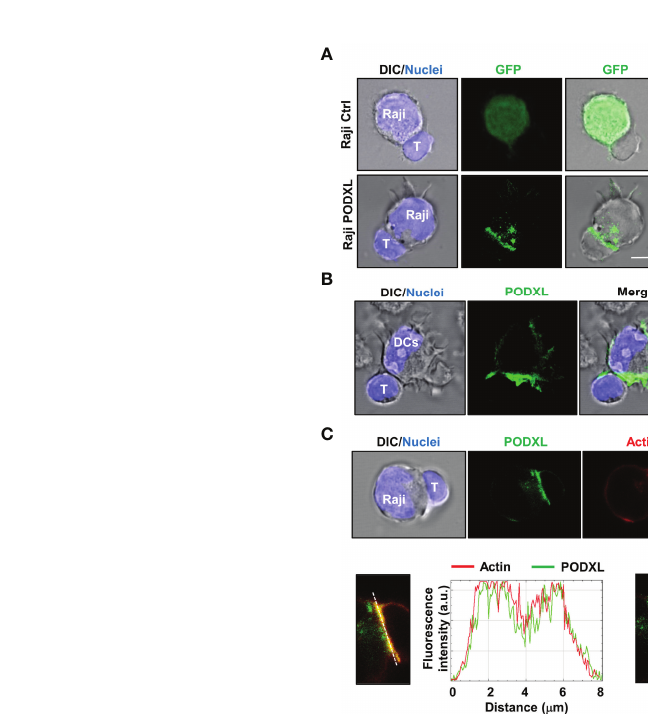
FIGURE 6 | PODXL expressed in APCs localizes to the T-cell contact side and partially colocalizes with actin. (A) Raji cells overexpressing PODXL-GFP and pulsed with SEA were incubated with CD4 + T cells at a ratio of 1:2 for 30 min. Images of conjugates comprising one Raji cell and one CD4 + T cell were obtained using confocal fl uorescence microscopy with a 63x objective and are representative of three independent experiments. The example shows maximal intensity z-projections of confocal fl uorescence sections. The position of PODXL in Raji-CD4 + T cell conjugates was determined using images obtained with a fl uorescence microscope and a 20x objective and scored as 1 when located in the quadrant close to the contact area, 2 and 3 when located at the intermediate quadrants, and 4 when present at the distal quadrant. Bar graph represents the percentage of conjugates with PODXL in each indicated position from three independent experiments and a total of 426 Raji-CD4 + T cell conjugates. The results are shown as mean ± SD. ****p < 0.0001, one-way ANOVA. (B) Immature DC were incubated with CD4 + T cells for 30 min and conjugates were analyzed with a 63x objective using a confocal fl uorescence microscope. Cells were stained with a goat polyclonal anti-PODXL antibody followed by an anti-goat Cy2- labelled secondary antibody (green), and Hoechst 33342 for nuclei staining (blue). Images show a representative immature DC-CD4 + T cell conjugate of 15 conjugates photographed from three independent experiments. Example shows maximal intensity z-projections of confocal fl uorescence sections. (C) Raji cells overexpressing PODXL-GFP (green) and pulsed with SEA were incubated with CD4 + T cells and stained for actin with Alexa 555-phalloidin (red) and for nuclei with Hoechst 33342 (blue). A confocal single z-section from a representative conjugate is depicted. An enlarged image of the region corresponding to the cell-to-cell contact zone is shown. Histogram depicts intensity pro fi les of PODXL (green) and actin (red) obtained using ImageJ-Fiji software, along an ideal line (white dashed line on the left image) crossing the contact zone of a representative conjugate. Bar graph represent the Pearson´s correlation coef fi cient of PODXL and actin colocalization at cell-to-cell contact site in Raji-PODXL cells conjugated with CD4 + T cells. A representative image showing the ROI selected for the quanti fi cation of colocalization is depicted (right image). Twenty two Raji-PODXL- CD4 + T cell conjugates from fi ve independent experiments were analyzed. Error bar displays the standard error. Scale bars in confocalimages correspond to 5